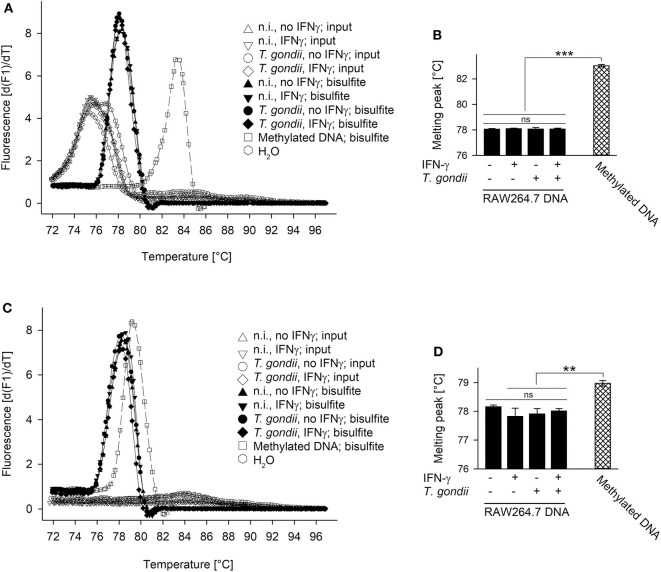
Promoters of irf1 and cIIta (pIV) in monocytic cells remain non-methylated during infection with T. gondii and/or stimulation with IFN-γ. RAW264.7 cells were infected or not with T. gondi and were stimulated or not with IFN-γ at 3 h p.i. DNA was isolated from the cells 24 h after infection and was subjected to bisulfite conversion; universally methylated DNA was treated in parallel and used as standard. Promoter regions of irf1
(A,B) and cIIta
(C,D) were qPCR-amplified from input sample DNA and from bisulfite-treated sample or standard DNA using methylation-independent primer pairs. Amplicons were subjected to methylation-sensitive melting curve analysis; (A,C) melting peaks were visualized by plotting the first negative derivative of fluorescence with respect to temperature vs. temperature. (B,D) Bars represent mean melting peaks ± S.E.M. (n = 5) of amplicons from bisulfite-treated sample and standard DNA as calculated by the LightCycler software; significant differences were identified by ANOVA (**p < 0.01; ***p < 0.001; ns, not significant).